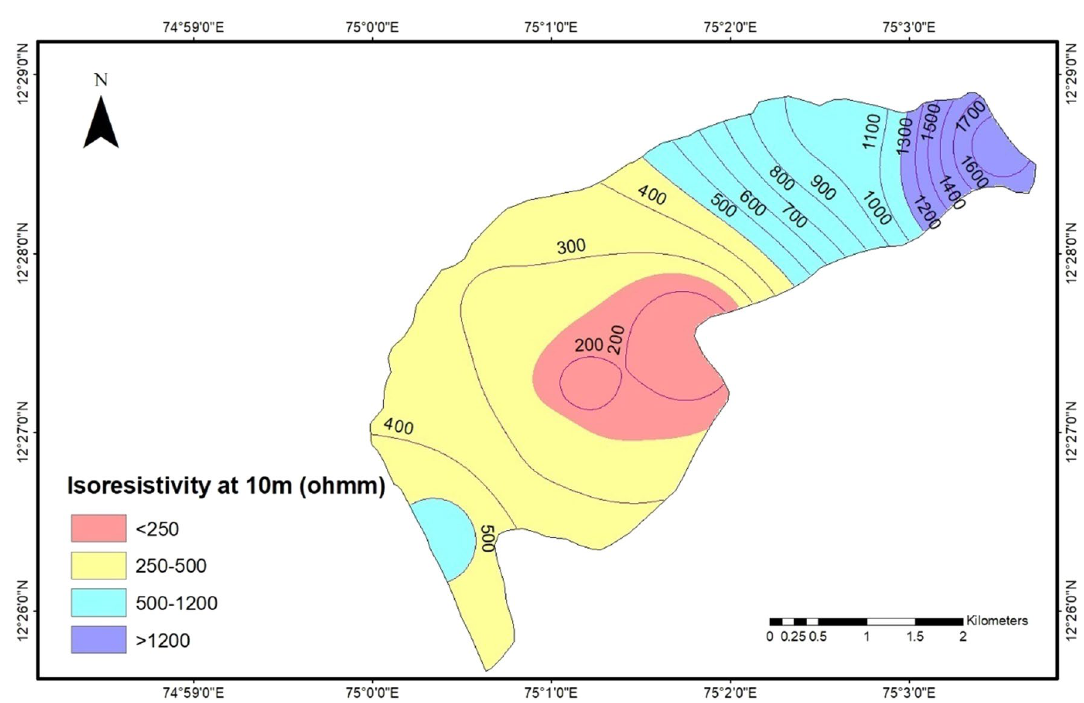
Fig. 9 Isoresistivity at 10 m depth of Kalanad river